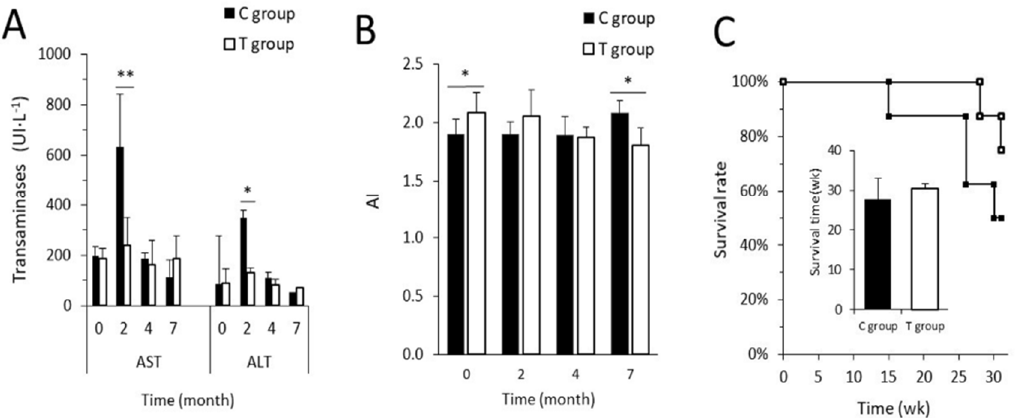
Figure 3. Transaminases level, atherogenic index and survival rate in ZDF rats. ( A ) Transaminase levels. Statistical significant di ff erences were observed in aspartate and alanine amino-transferases (AST and ALT) at two months of study, being that the C group clearly shown higher concentrations of both AST (632.1 ± 208.9 versus 238.9 ± 112.6 UI L − 1 in C and T groups, respectively; p = 0.001) and ALT (348.0 ± 192.2 versus 90.0 ± 54.6 UI L − 1 in C and T groups, respectively; p = 0.019). ( B ) Atherogenic index. Statistically significant di ff erences were observed in basal (1.9 ± 0.1 versus 2.1 ± 0.1 in C and T groups, respectively; p = 0.004) and end point values of atherogenic index (AI) (2.1 ± 0.2 versus 1.8 ± 0.1 in C and T groups, respectively; p = 0.015). ( C ) Kaplan-Meier plot. The T group demonstrated a greater survival rate (87.5%) compared to the C group (50%). The survival time was higher in the T group (27.6 ± 5.6 versus 30.6 ± 1.1 weeks in C and T groups, respectively, p = 0.106) but no significant di ff erences between both groups were found. Data are represented as mean ± SD. * p < 0.05; ** p < 0.01.